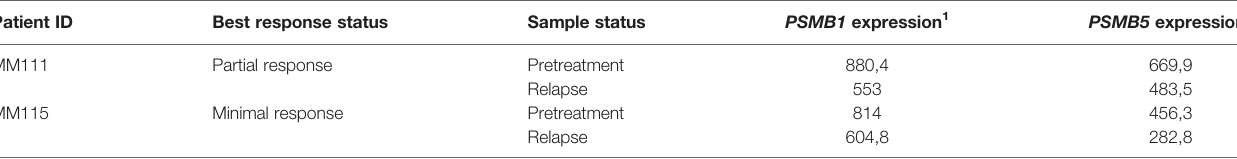
TABLE 7 | Normalized expression levels of bortezomib targeting genes in MM patients before and after PAD/VCD treatment. Patient